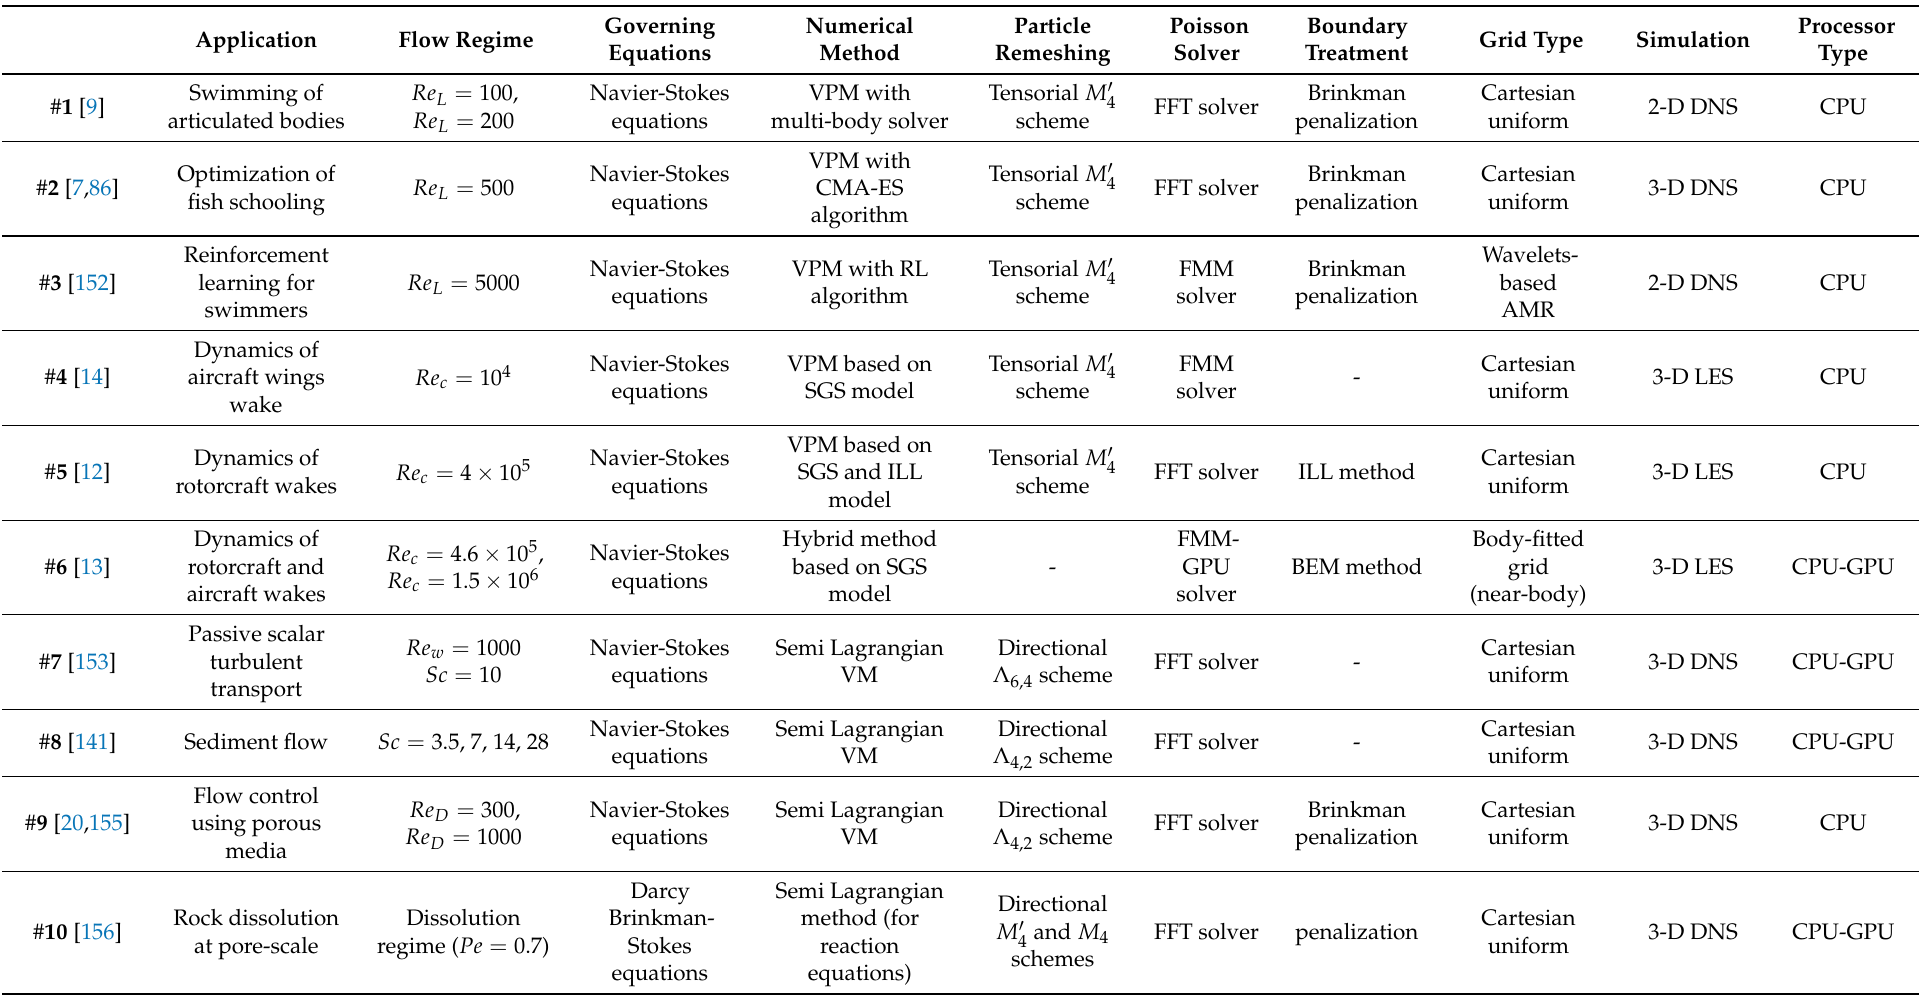
Table 1. The main physical and numerical characteristics of the simulations presented in Section